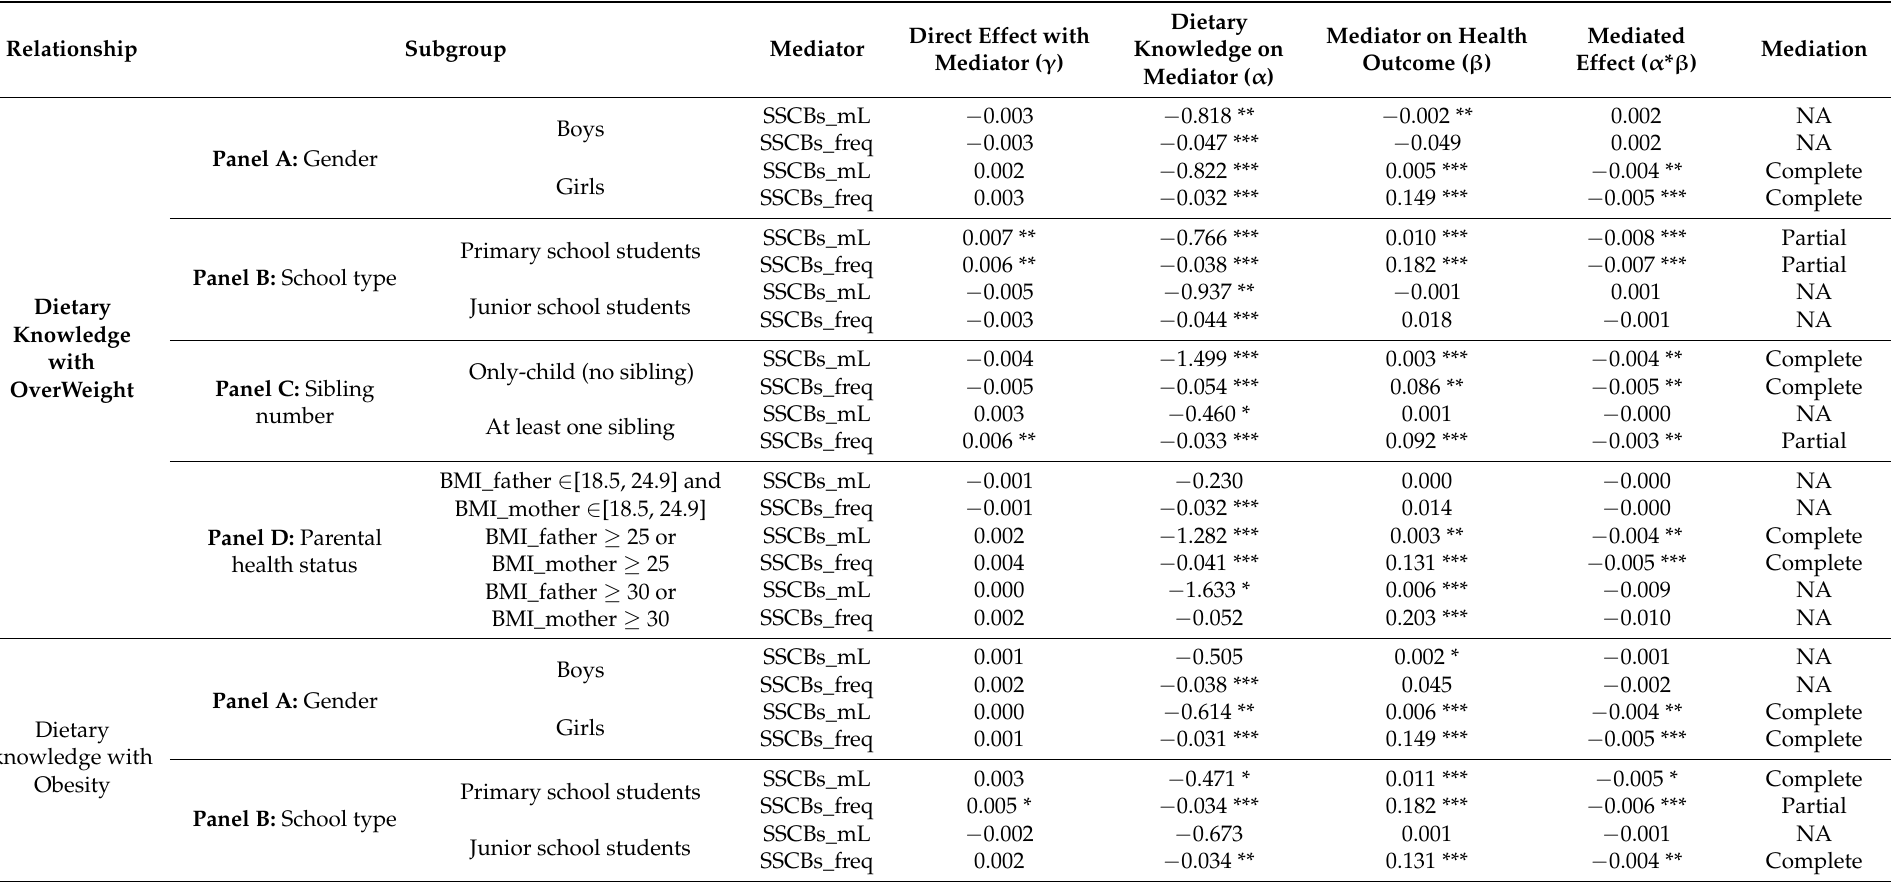
Table 6. Mediation analysis based on standardized regression weights from simultaneous equation modeling (for